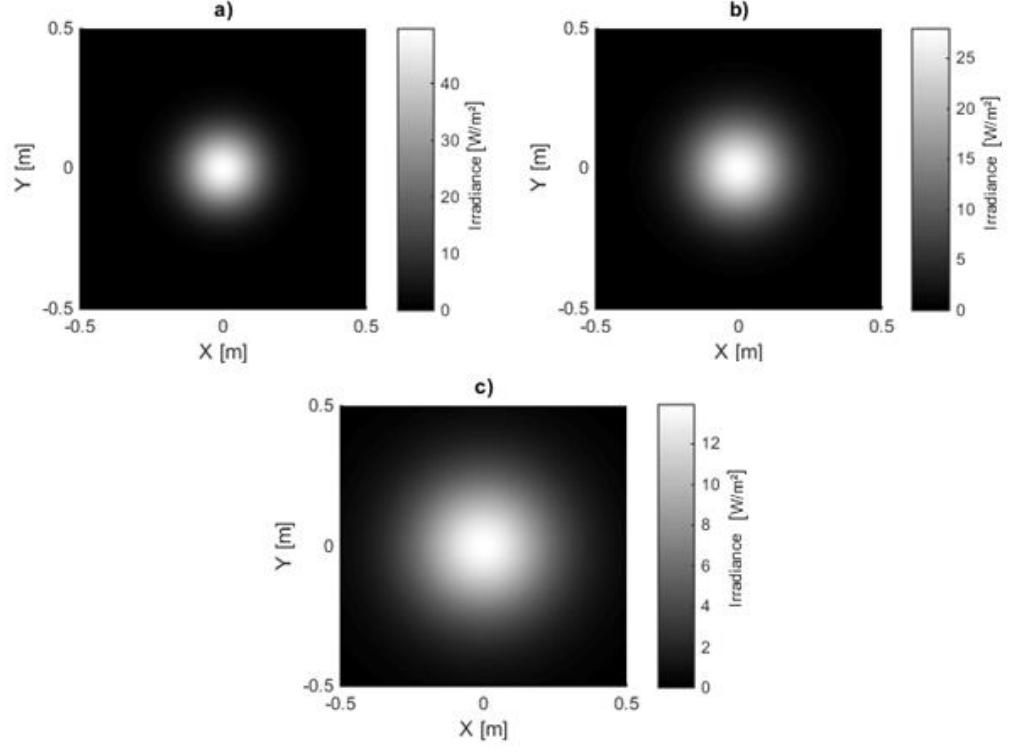
Figure 6. Simulated light distribution pattern at 0.6 m distance from LED 4 for ( a ) Narrow; ( b ) Medium; ( c ) Wide angle